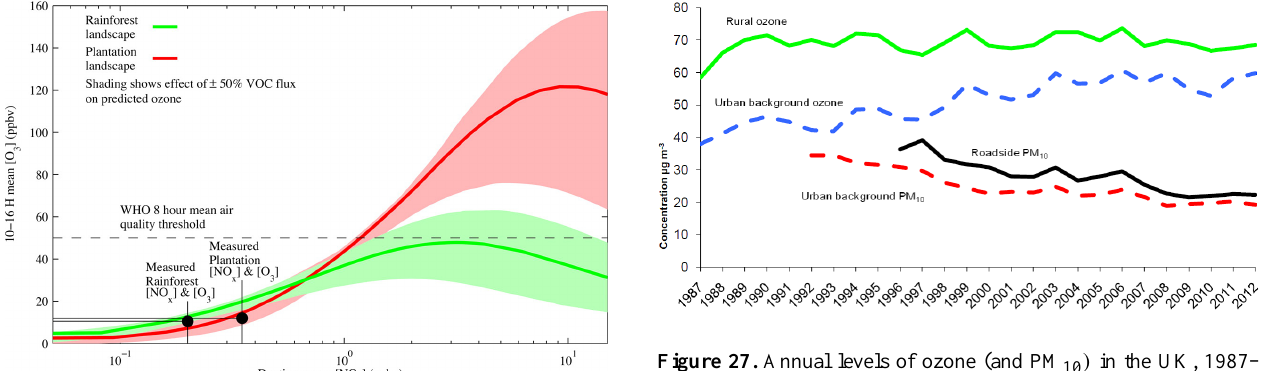
Figure 27. Annual levels of ozone (and PM 10 ) in the UK, 1987– 2012 (Defra, 2013), showing the rise of urban ozone concentrations towards the rural ones and the relatively flat rural concentrations over the last